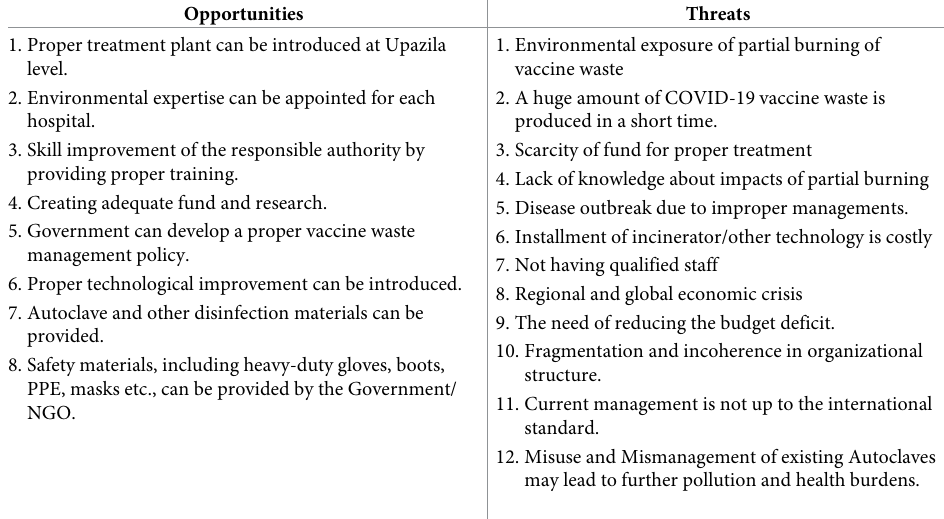
Table 9. SWOT analysis for COVID-19 vaccine waste management (opportunities and